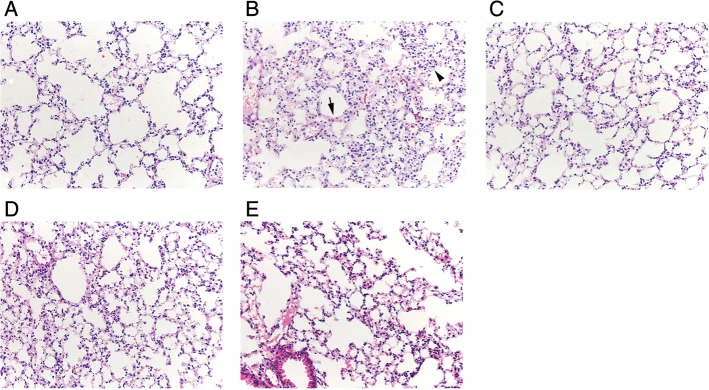
Pathological changes in lung tissue at 2 weeks after radiation in each group. HE staining showed that the normal structure of lung tissue was observed in Group C (A). Thickened alveolar walls (arrow), pulmonary capillary expansion, and hyperemia and inflammatory infiltration foci (arrowhead) were found in Group R (B). Alleviation of these pathological changes was observed in Groups U, M and UM (C–E).